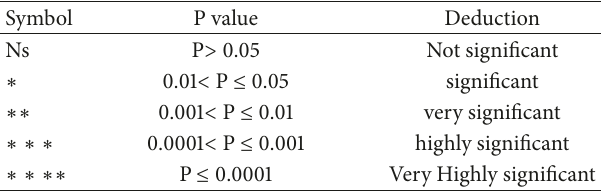
Table 2: Assessment of the significance. Symbol P value